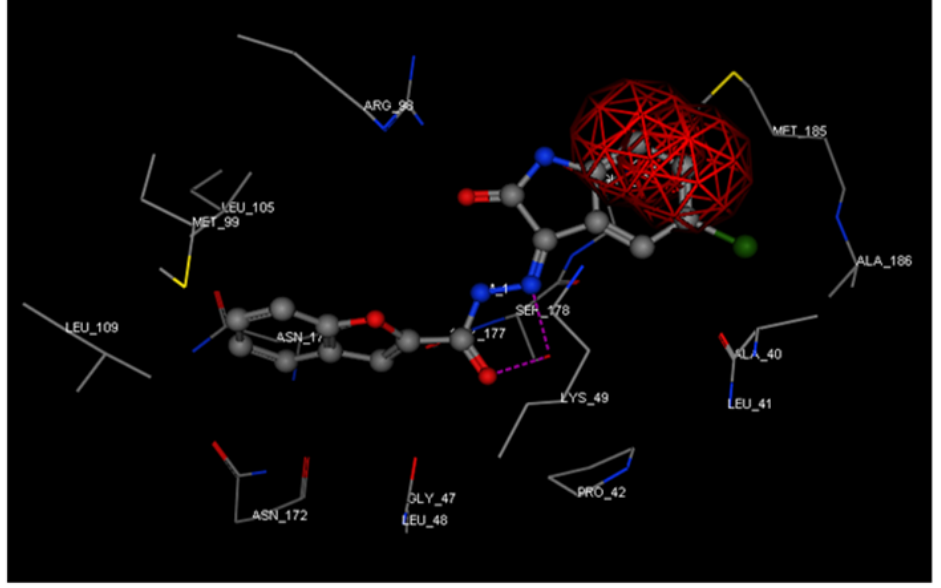
Figure 3. Compound 17 (ball and stick) docked into 3ilw active site. Steric clash shown as a red